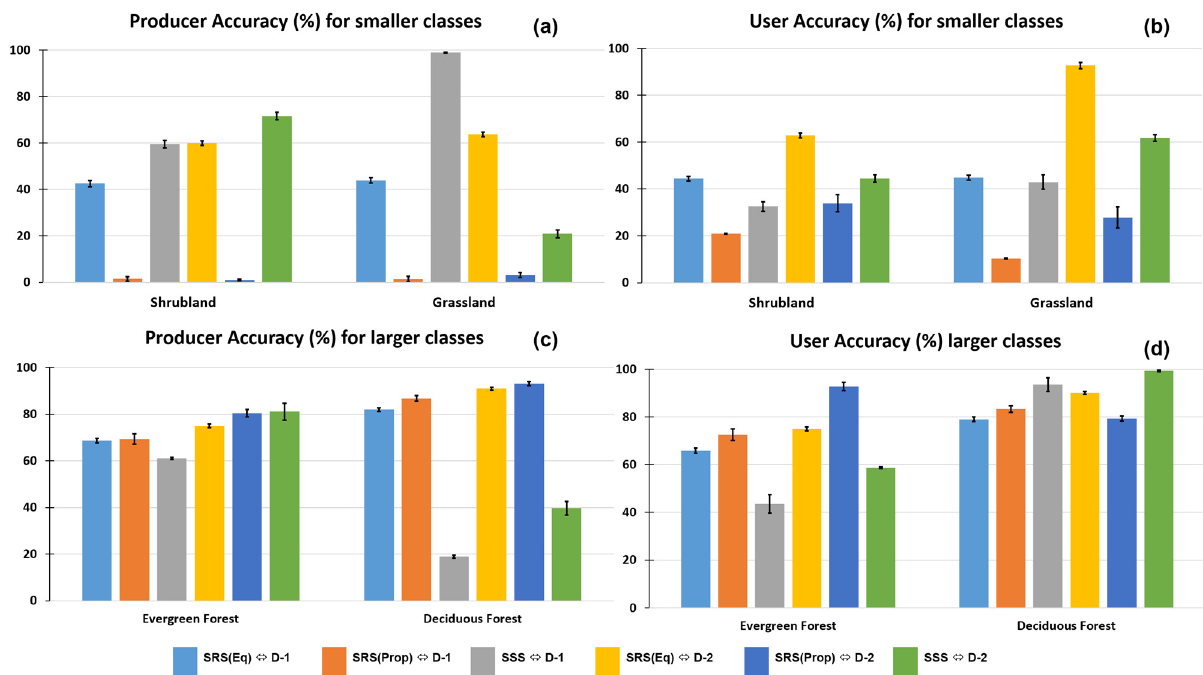
Figure 6. Average producer’s and user’s accuracies of smaller ( a , b ) and larger ( c , d ) land cover classes for different sampling methods obtained using the RF classifier. The error bars indicate the standard deviation of overall accuracy for 100 trials. Sample sizes of 9000 and 8460 are taken for stratified random sampling methods (SRS(Prop) and SRS(Eq)) and the stratified systematic sampling method (SSS), respectively.